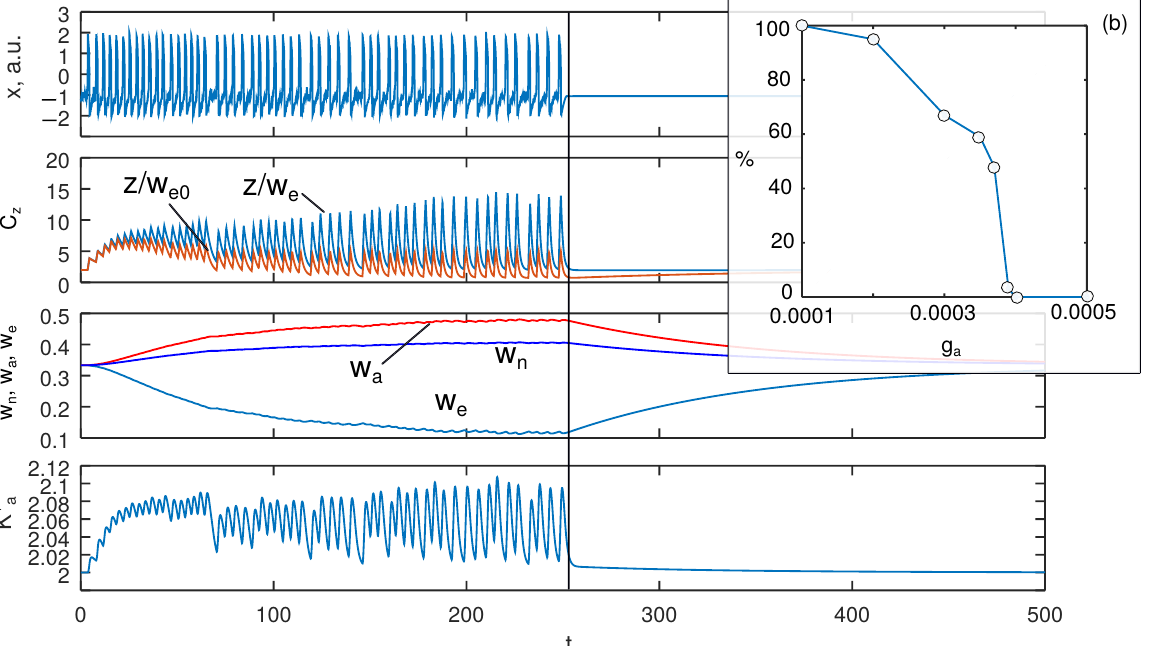
Figure 4. Model behavior when astrocytic potassium reuptake is active. ( a ) Gaussian noise with D = 0.17 acts from t = 0 till t = 250. The time courses of model variables show the slow decrease in w e , which provides the extra rise of C z = z / w e , compared with curve z / w e 0 for the constant volume case. ( b ) The increased contribution from astrocytic potassium reuptake rapidly prevents self-sustained neuronal firing. All displayed quantities are